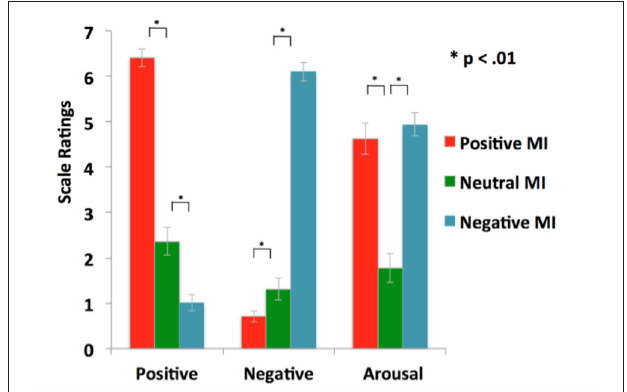
FIGURE 2 | Mood manipulation check: illustration of successful positive and negative mood inductions (MI) that enhanced the target mood state, relative to the neutral